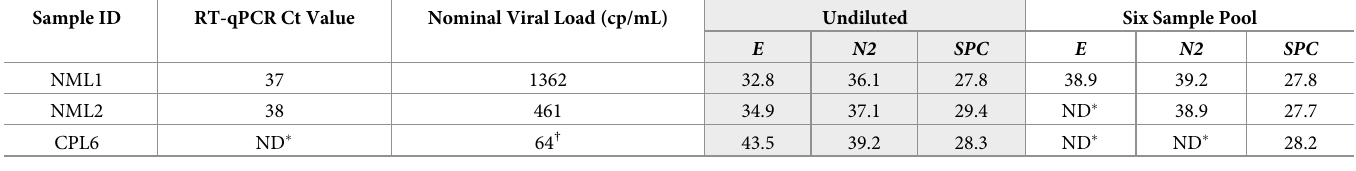
Table 2. An additional three clinical specimens with high Ct values were selected to observe the effect of sample pooling close to the limit of detection of the Xpert 1 Xpress SARS-CoV-2 assay . This included two samples provided by the National Microbiology Laboratory and one from the Cadham Provincial Laboratory (CPL), which is a discordant sample not detected by CPL’s Corman RT-qPCR test, but detected as a weak positive by the Xpert 1 assay. At the six-fold dilution, the weak positive was no longer detected by the